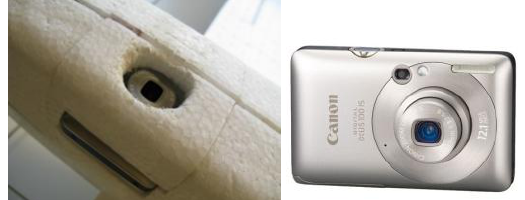
Figure 3: Used consumer camera and mounting position on UAV